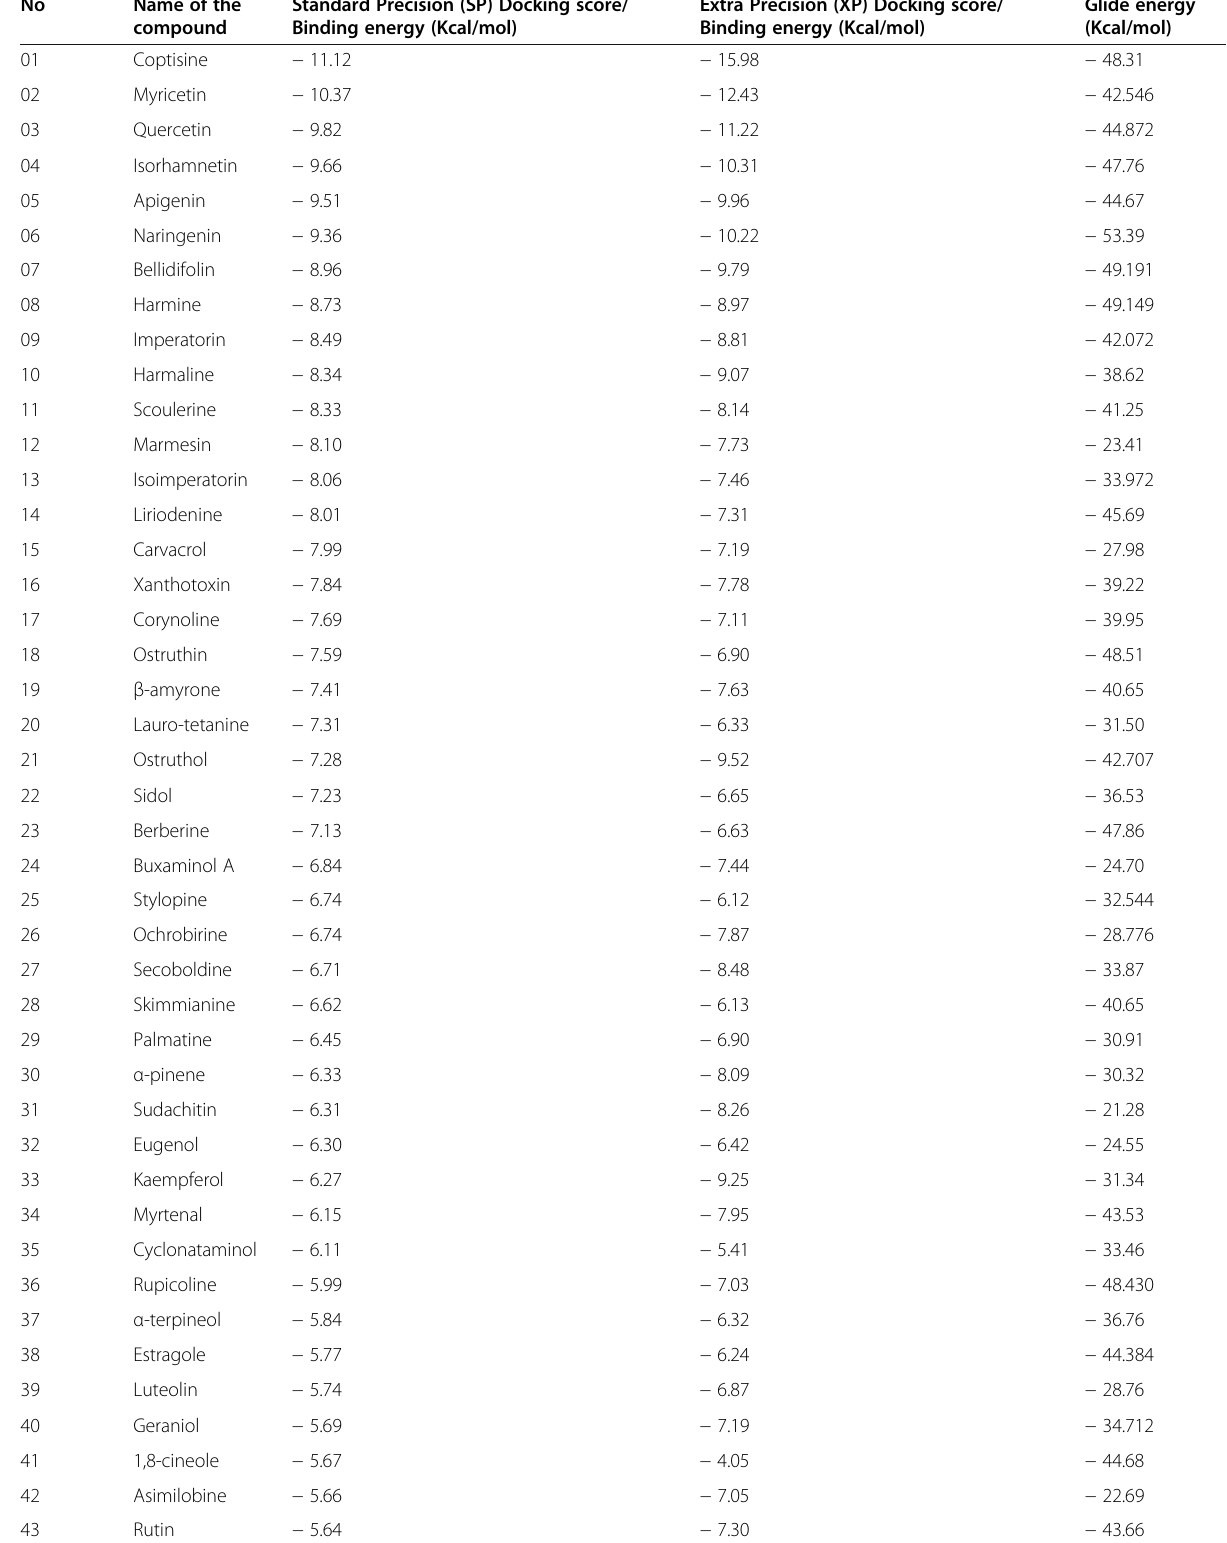
Table 3 The results of the SP and XP docking study of the selected ligands along with their respective glide energies